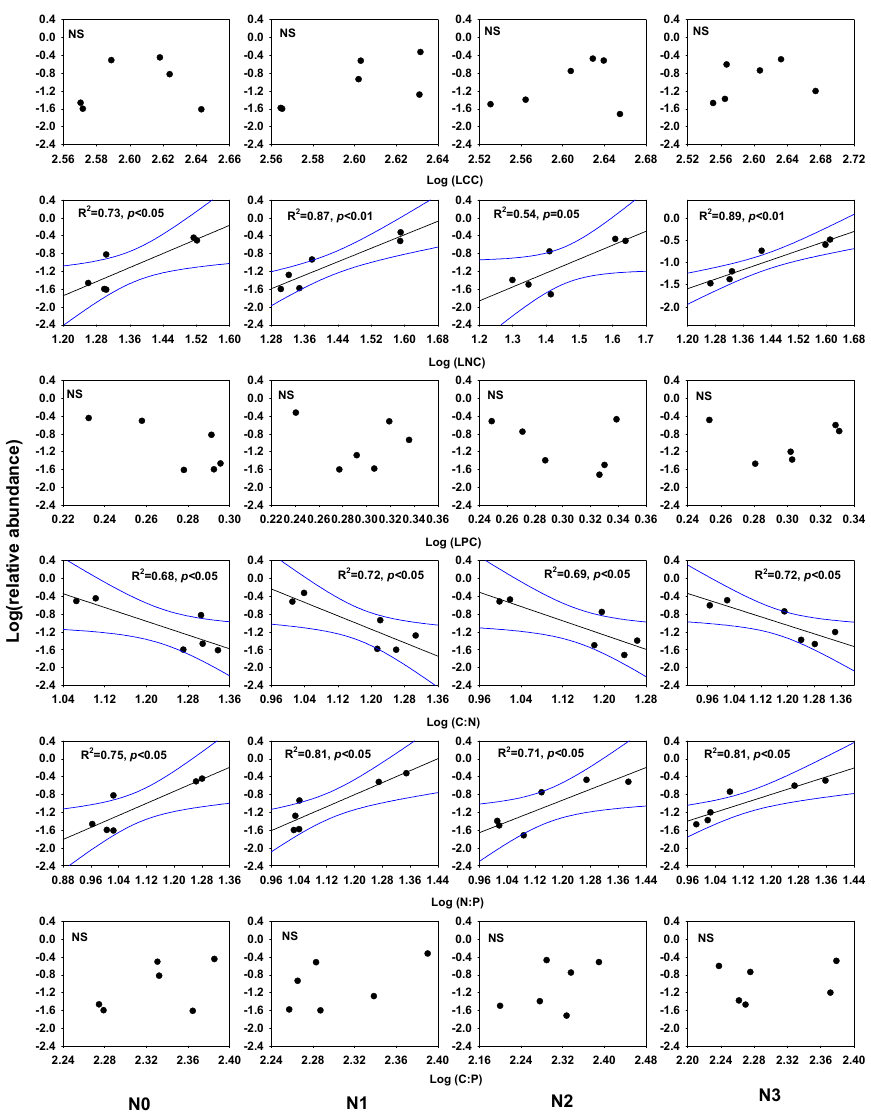
Figure 3. Relationships between species’ relative abundance and ecological stoichiometric traits among common species in the control and nitrogen addition plots. N0, N1, N2, and N3 indicate nitrogen addition amounts of 0, 3, 6, and 12 g/m 2 , respectively.